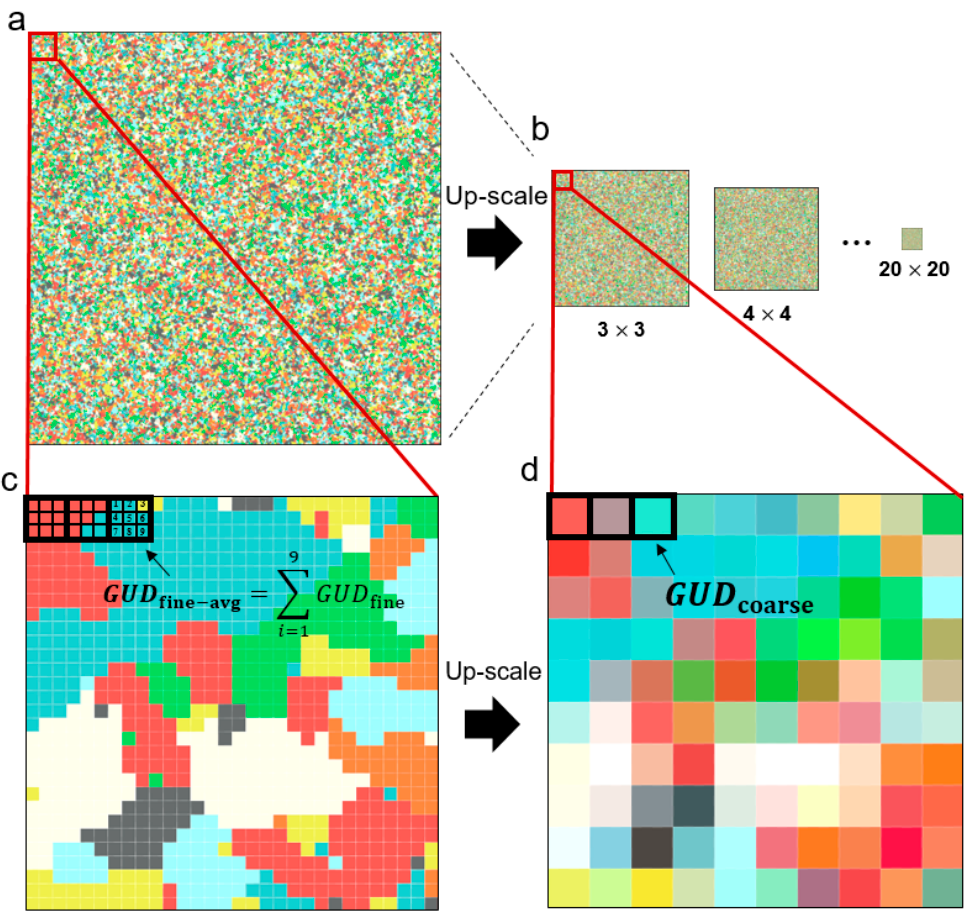
Figure 5. Up-scaling from the fine resolution images to coarser images: ( a ) fine resolution image, ( b ) up-scaled coarser images at different scales. ( c , d ) The example of up-scaling of 3 × 3 pixels and the corresponding calculation of GUD fine − ave and GUD coarse